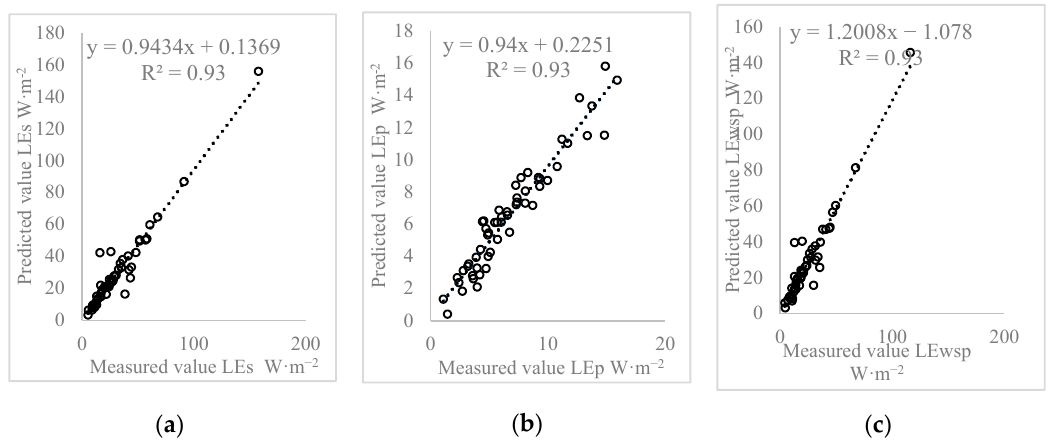
Table 3 . Results of root mean square error (RMSE) and Nash-Sutcliffe efficiency (NSE) when simulating 𝐿𝐸 (cid:3046) , 𝐿𝐸 (cid:3043) and 𝐿𝐸 (cid:3050)(cid:3046)(cid:3043) (W ∙ m (cid:2879)(cid:2870) ) .